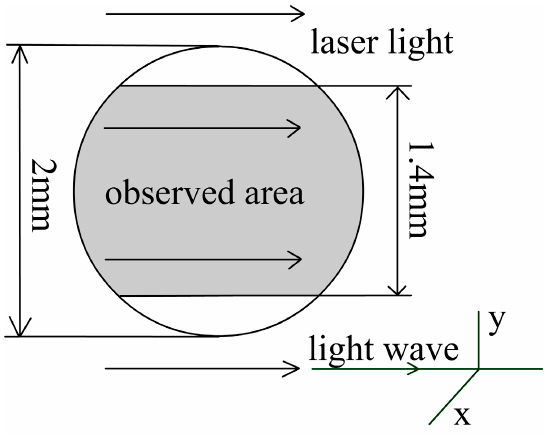
Figure 2. The observed area (gray) on the electrode surface: The X axis is in horizontal direction from the electrode surface toward the bulk electrolyte while the Y axis is in the opposite direction of gravity.